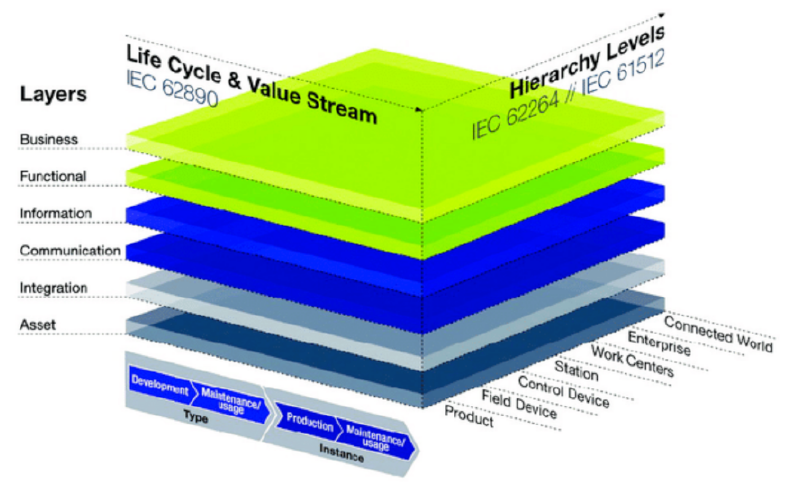
Figure 1. Three-dimensional structure of the reference architecture model for Industry